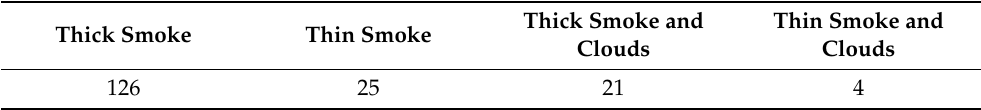
Table 1. The distribution of the four categories for the forest fire smoke dataset.